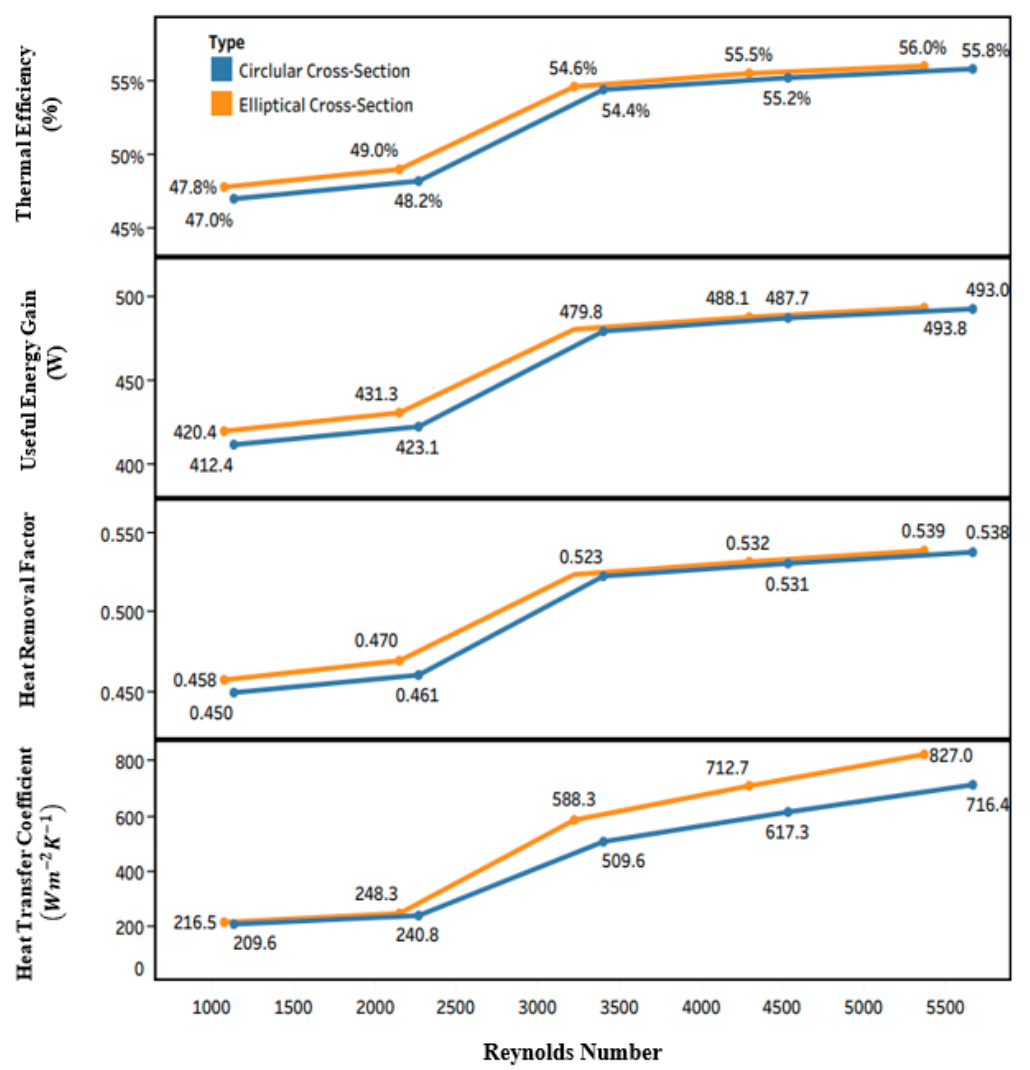
Figure 9. Effects of the 𝑅𝑒 on ℎ (cid:3033)(cid:3036) , 𝐹 (cid:3019) , 𝑄 (cid:3048) , and 𝜇 (cid:3021)(cid:3035) .